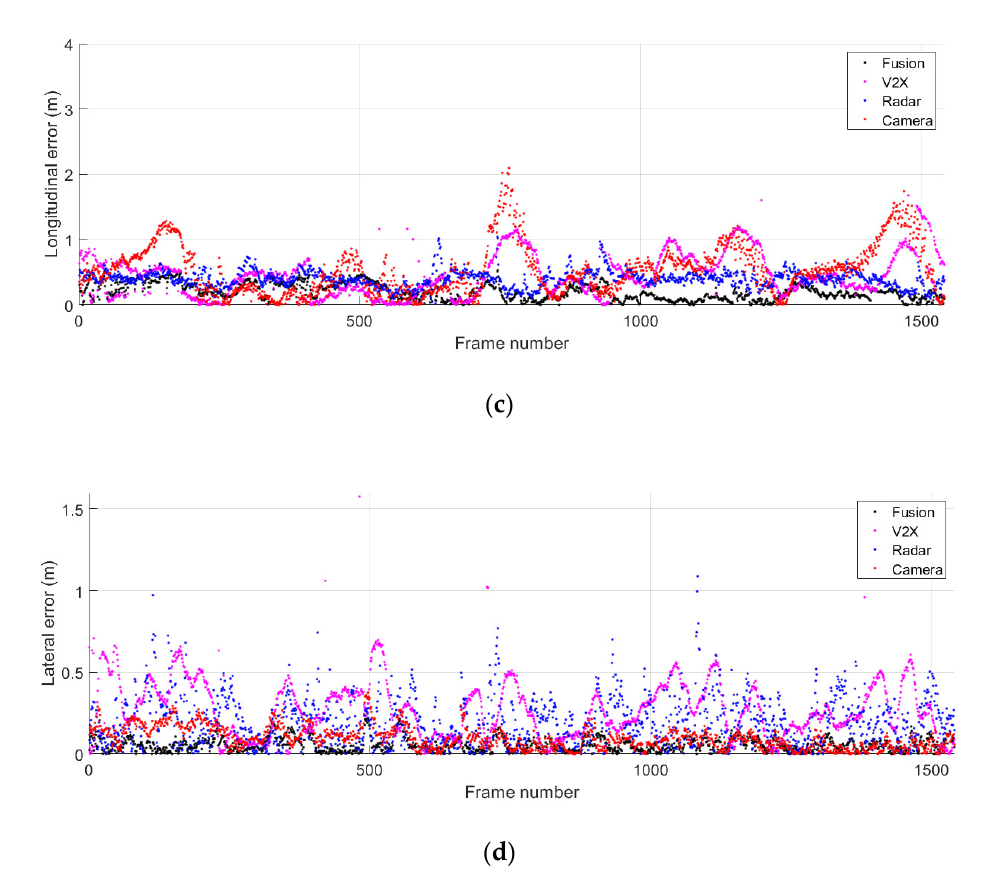
Figure 15. Relative distance to the remote vehicle during the cut-in driving scenario 2. ( a ) Ground truth longitudinal distance; ( b ) ground truth lateral distance; ( c ) absolute error for longitudinal distance estimates; ( d ) absolute error for lateral distance estimates.